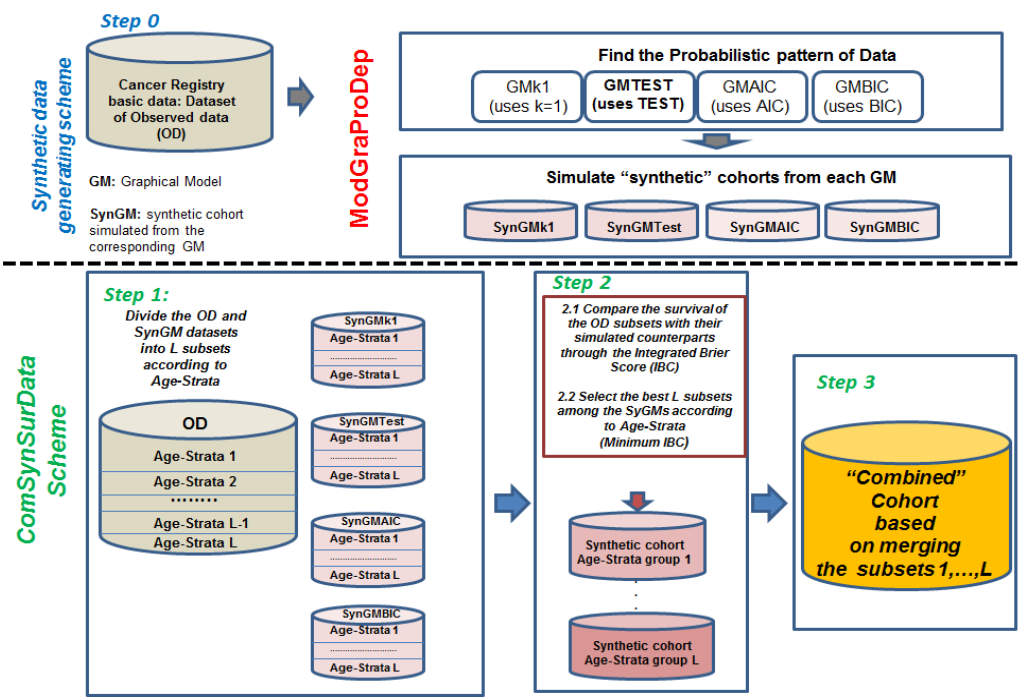
Figure 1. Scheme of procedure for generating combined cohort by using best synthetic cohort for each of the considered L age-stratum groups. Synthetic cohorts generated according to Mod-GraProDep.